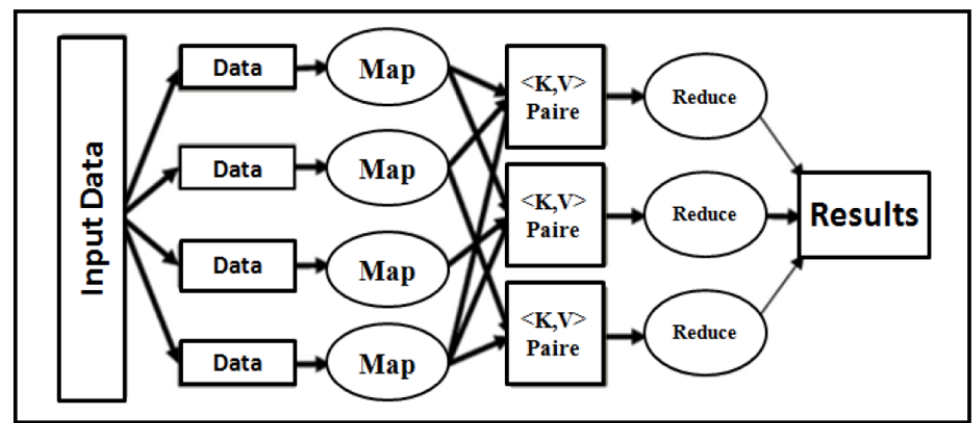
Figure 2. MapReduce